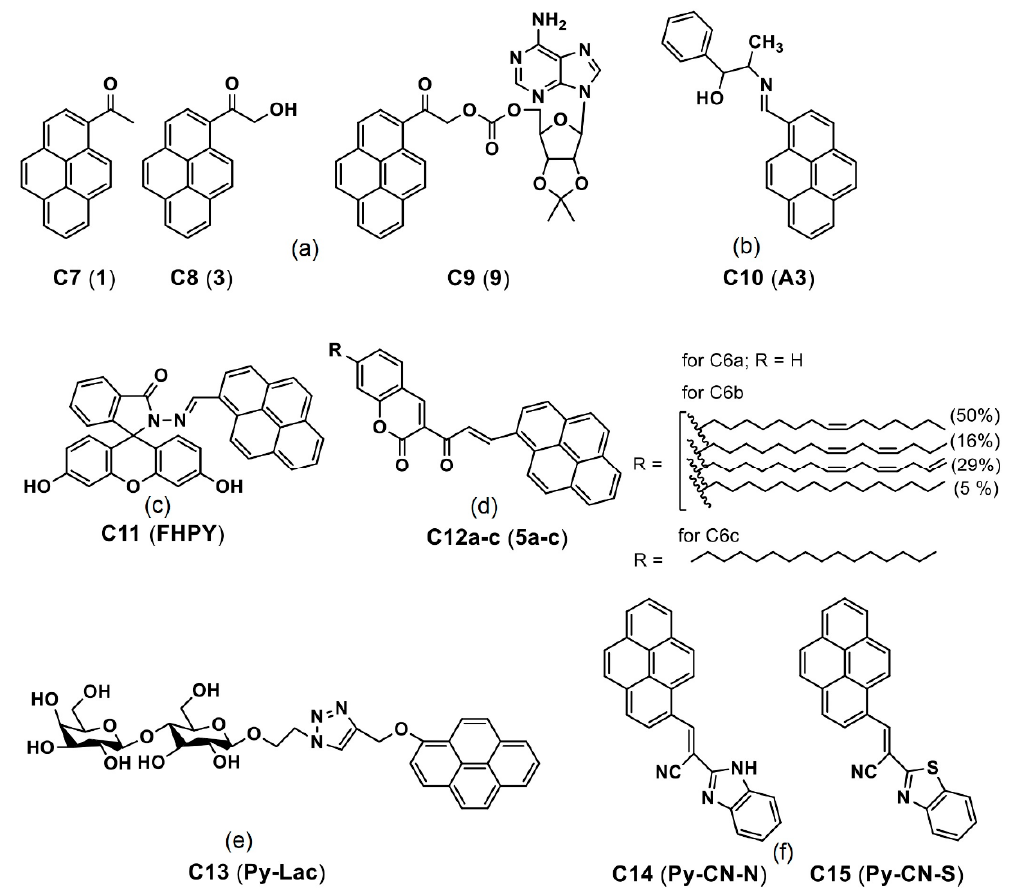
Figure 9. ( a – f ) C7 – C15 are the chemdraw structures of pyrene-based AIEgens, small molecules and dyes reported for in vitro / in vivo imaging (Note: the original representation or numbering of the molecules were provided in the brackets along with respective reference numbers).